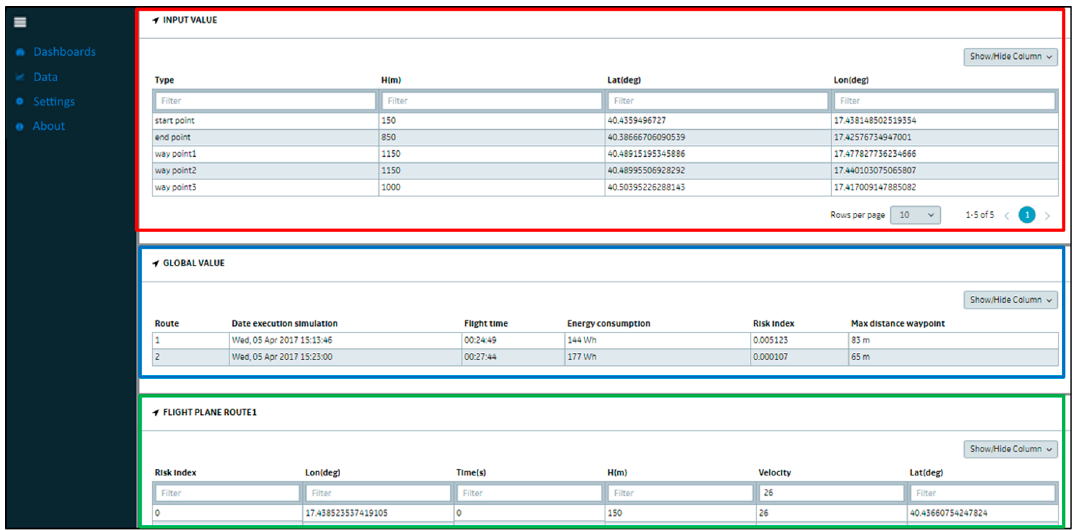
Figure 5. FLIP data visualization.